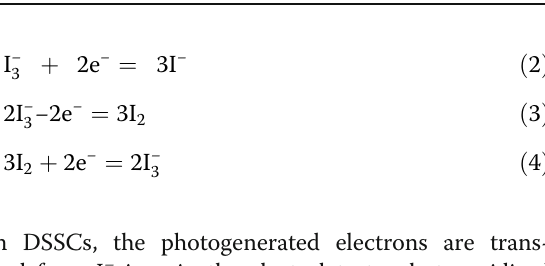
Fig. 5b, for the cases of MWCNT-added carbon